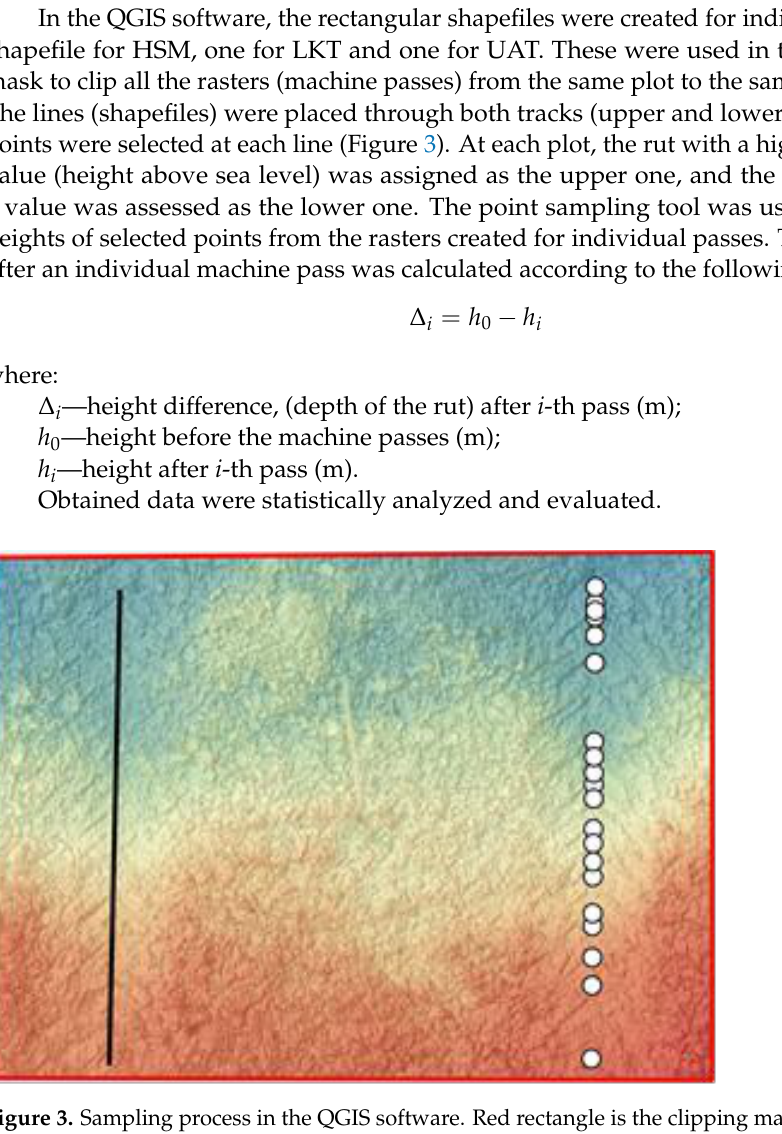
Figure 3. Sampling process in the QGIS software. Red rectangle is the clipping mask; black line is the sample line (basis) for the selection of random points (white dots in the picture).